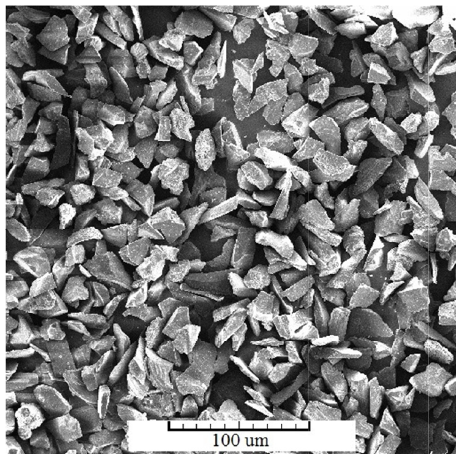
Fig. 1. SEM image of SiC